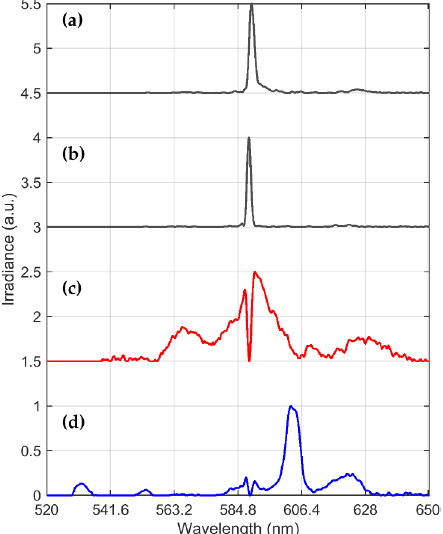
Figure 7. Extraction of spectral features with MCR-ALS from PyE pyrite sample combustion, each spectrum is normalized to its maximum: ( a , b ) are associated to a sodium doublet, named as I 1 and I 2 for subsequent analysis, ( c ) is associated with FeO emission, I 3 and ( d ) emission of other iron oxides emission, I 4 . Obs . Spectral features are normalized to their maximum and offsets to each spectrum are included for comparison purposes.